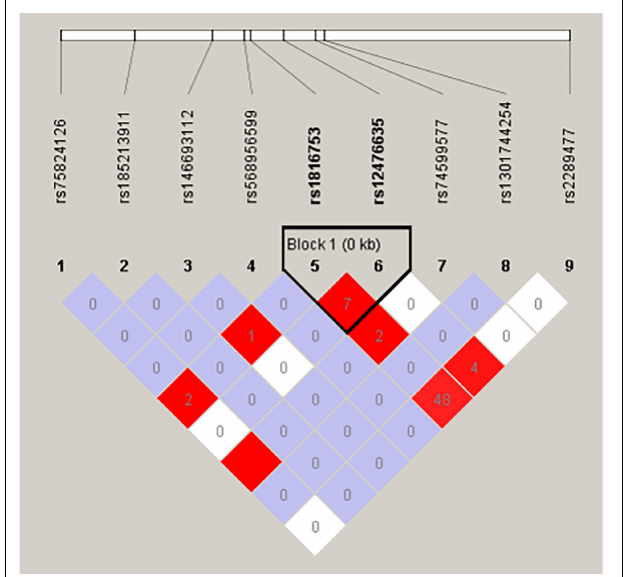
FIGURE 3 | The LD tests of the Nine SNPs in AMI. Standard color schemes indicate different levels of LD. Standard Color Scheme: White: LOD < 2, D (cid:48) < 1; Blue: LOD < 2, D (cid:48) = 1; Bright red, LOD > 2, D (cid:48) = 1; LOD: the log of the likelihood odds ratio, is a measure of confidence in the value of D (cid:48) . Shown LD value: R-squared. The box is empty indicates that the r2 value is